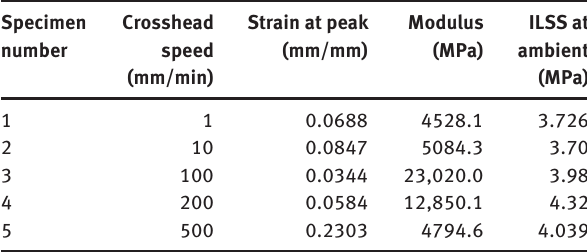
Table 1 ILSS values and modulus of ambient Kevlar/epoxy sample.